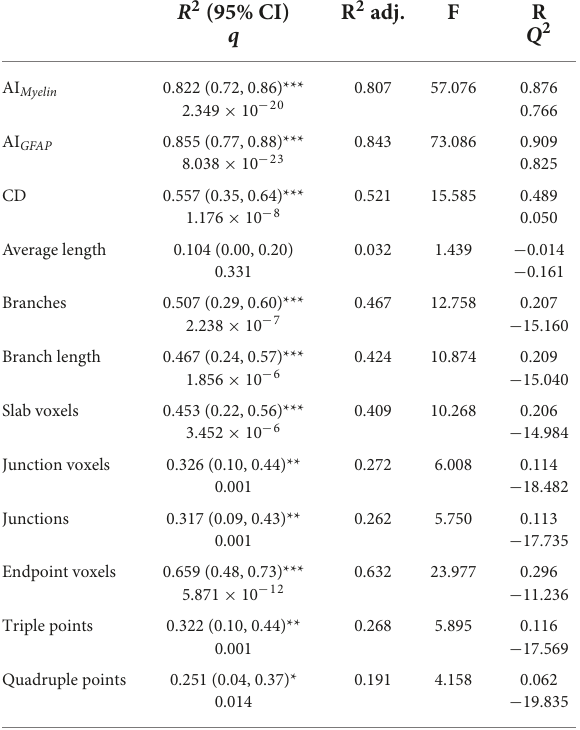
TABLE 3 Multiple linear regression analyses between DTI and histological parameters and leave-one-animal out cross-validation. R 2 (95% CI)